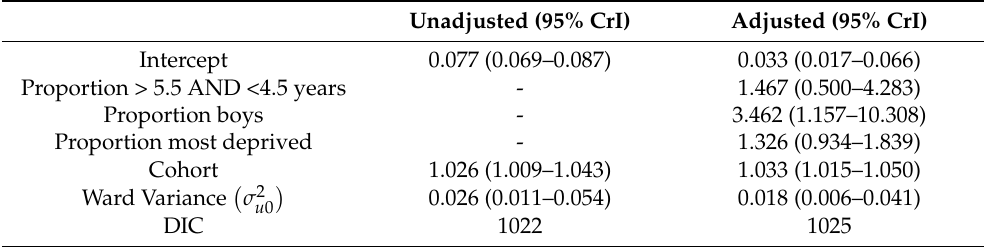
Table 2. Disease mapping